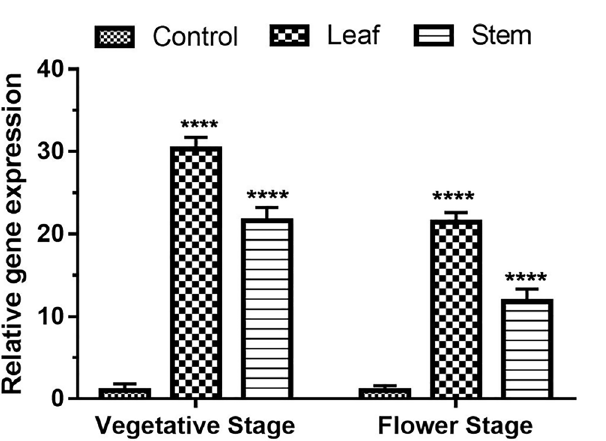
Figure 6. Quantitative real time PCR to determine the expression of transgenic cotton plants ( GaZnF ). mRNA samples of Line PF0054 exhibit the different expression levels at both vegetative and flower stages in leaf and stem tissues of transgenic and control plants, GAPDH was used as an internal control for normalization. The means ± SD of three biological replicates are presented. Error bars represent the standard deviation of the mean. Above the bars **** represent significant expression level of transcript in transgenic plants as compare to non- transgenic plants at the P < 0.05 level according to LSD multiple range